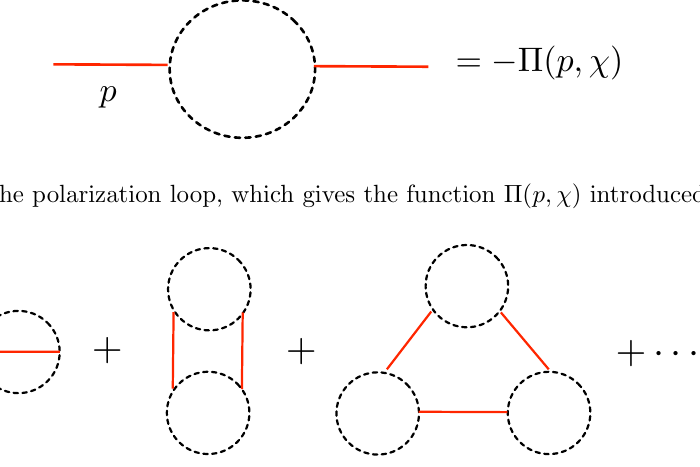
( (cid:30); (cid:31) (1)